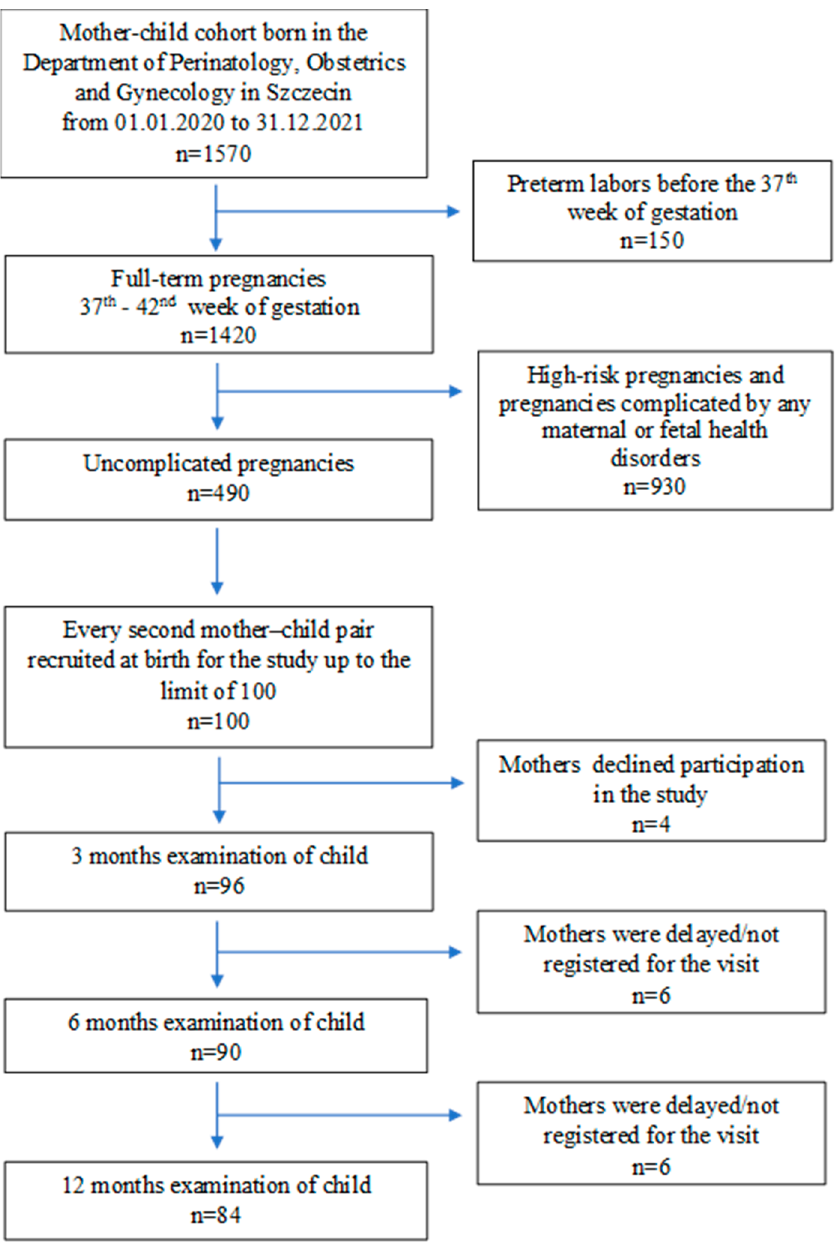
Figure 1. Flow chart of recruitment of mother–newborn pairs and data collection process.